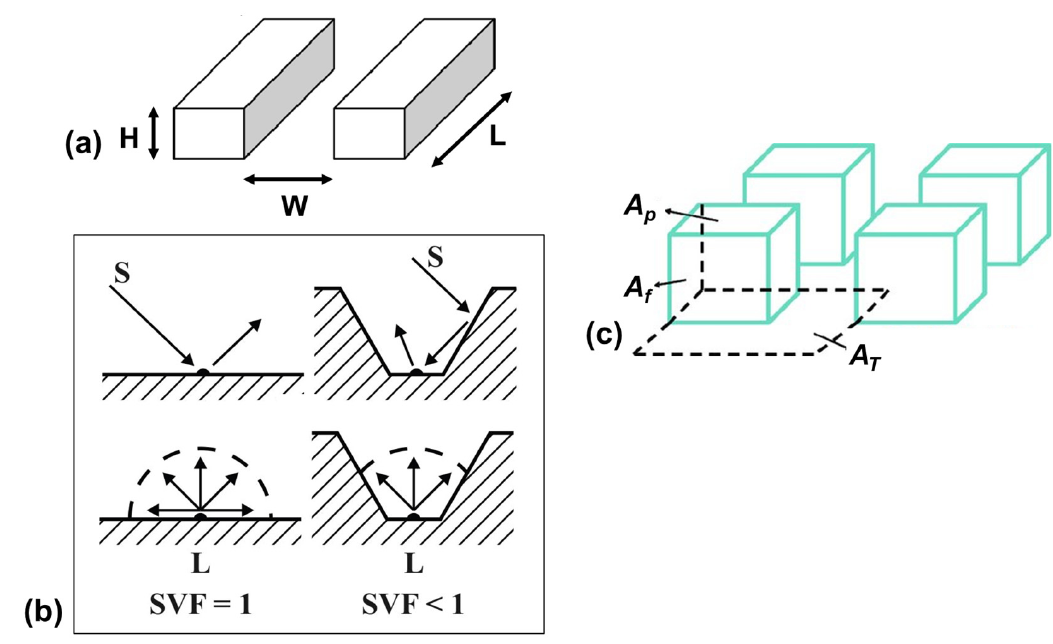
Figure 2. ( a ) Geometric symmetric street canyon. H = building height, W = street width, L = building length; ( b ) the role of surface geometry in radiation exchange. Comparison of horizontal and convoluted surfaces. S = short ‐ wave radiation, L = long ‐ wave radiation (adapted from Hämmerle et al. [27]); ( c ) definition of plan area, A p , frontal area, A f , and total area, A T , for the calculation of plan area index and frontal area index (adapted from Chen et al. [28] ©Elsevier).